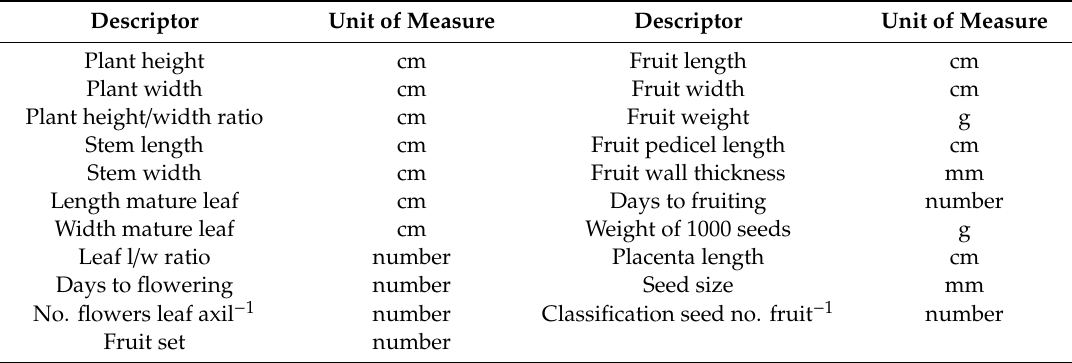
Table 3. Capsicum morphological quantitative